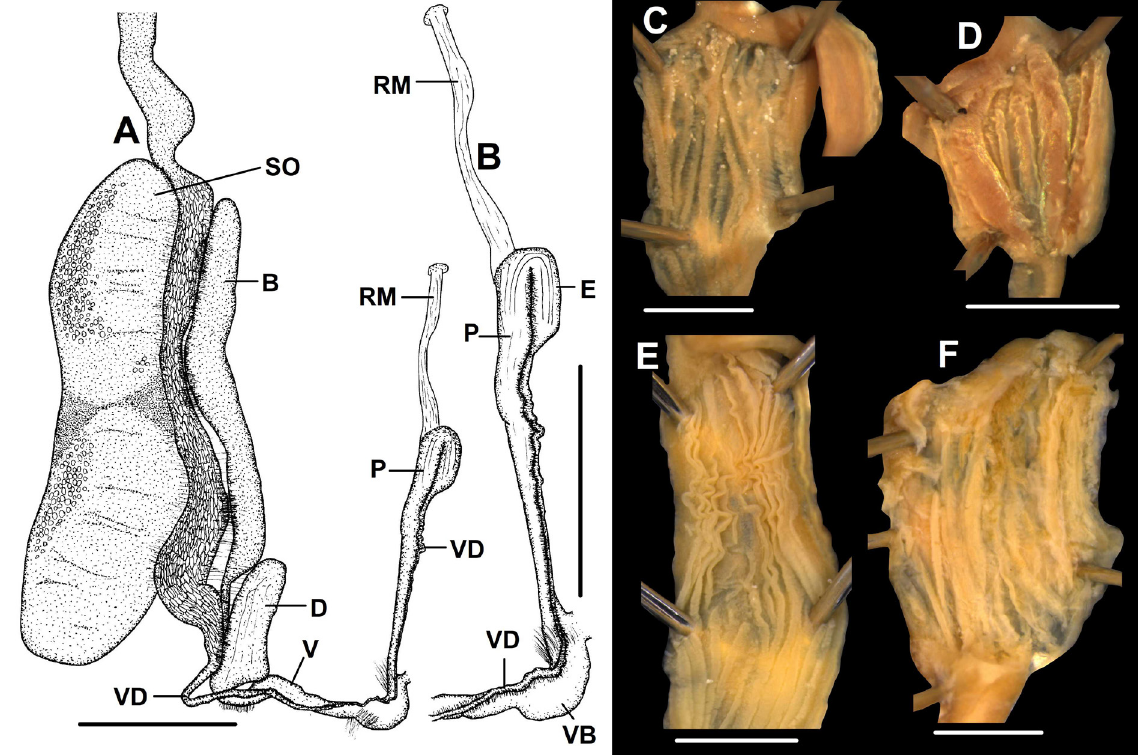
Fig. 39. Genitalia of Plectopylis cairnsi Gude, 1898, PL012 (UF 76467). A . Distal genitalia. B . Male genitalia (penis, epiphallus, vas deferens). C–F . Inner structure of genital organs (C = penis, D = epiphallus, E = vagina, F = diverticulum). Scale bars: A–B = 5 mm; C–F = 1 mm. For abbreviations see Fig. 2. All photos: B.